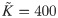
Probability of outbreak in terms of the initial population size.The population is controlled by (A) ALC and (B) ATH. Population dynamics are deterministic (σ = 0) or with demographic stochasticity (σ = 1). Calculations are based on Models (1) and (2) with r = 4.5, K˜=400 and s = 0.002 (L ≈ 6.015). Population outbreaks are considered to occur when the number of individuals exceeds (K + f(d))/2. For a given initial population size, the outbreak probability has been obtained for the first 100 generations and over 1000 replicates.